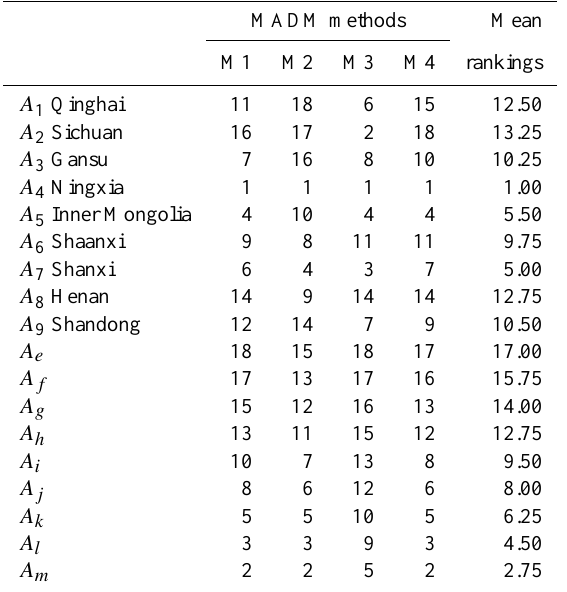
Table 7. Summary of indicator values in average ranking